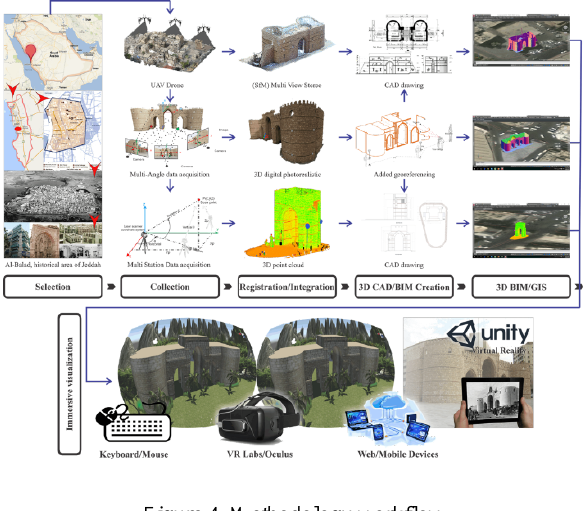
Figure 4. Methodology